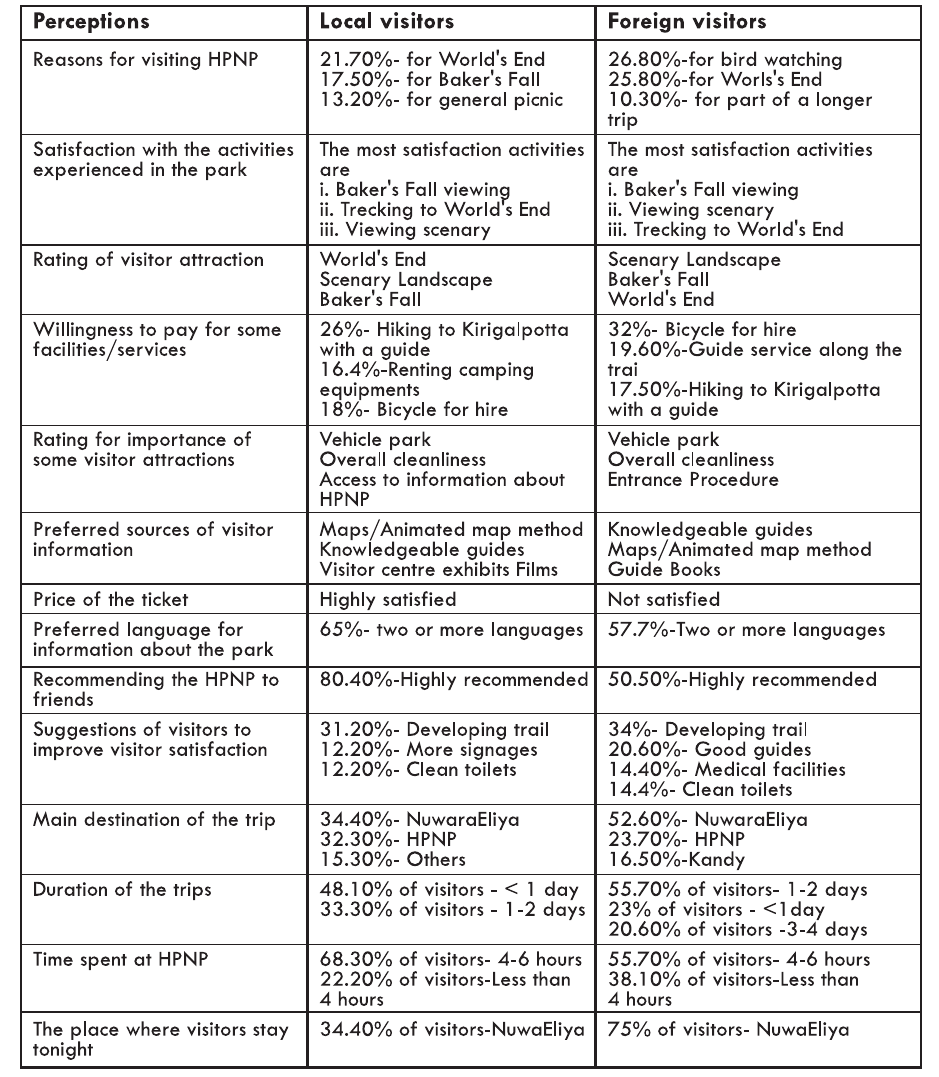
Table 2: Summary of visitor perceptions at